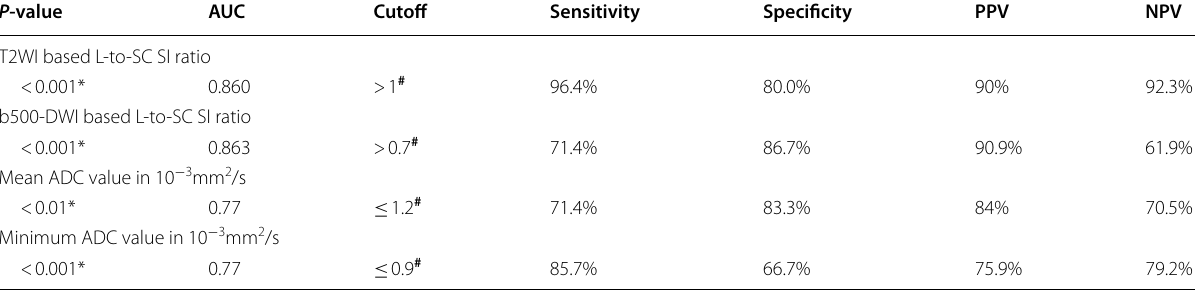
Table 2 Comparative analytic performance of quantitative MRI parameters